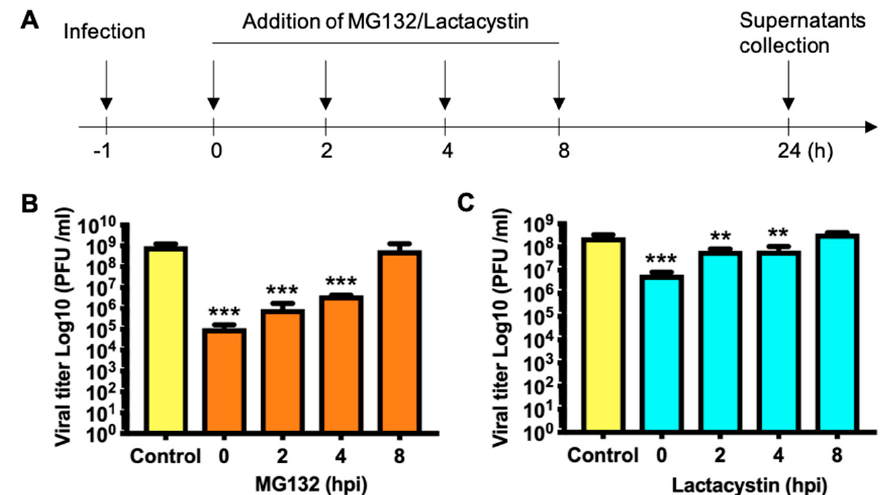
Figure 4. MAYV requires proteasome activity at the early stages of infection. ( A ) Schematic representation of the experiment applying the proteasome inhibitors at different times after infection. HeLa cells were infected with MAYV as described above. MG132 ( B ) or Lactacystin ( C ) was added at the indicated time after infection. In control cells, DMSO (0.1%) or water was added at 0 h. At 24 h of infection we assessed viral yield production in the cell supernatants. Viral titers were expressed as PFU/mL. Data were analyzed with the One-way ANOVA test using GraphPad software and are shown as mean ± SD. Statistically significant differences are indicated: ** p < 0.01, *** p < 0.001.